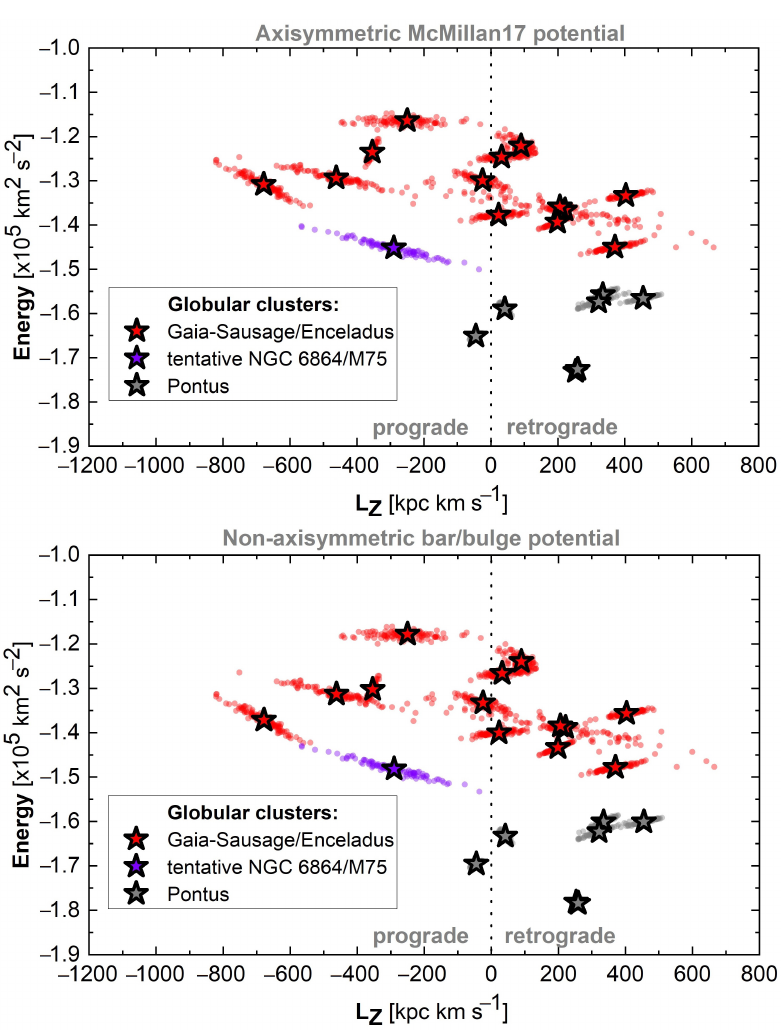
Figure 4. Positions of the globular clusters on the ( L z , E ) -plane for two galactic potential models, the axisymmetric model of McMillan17 (top panel) and a non-axisymmetric model (bottom panel). Asterisks mark the mean values of L z and E on the